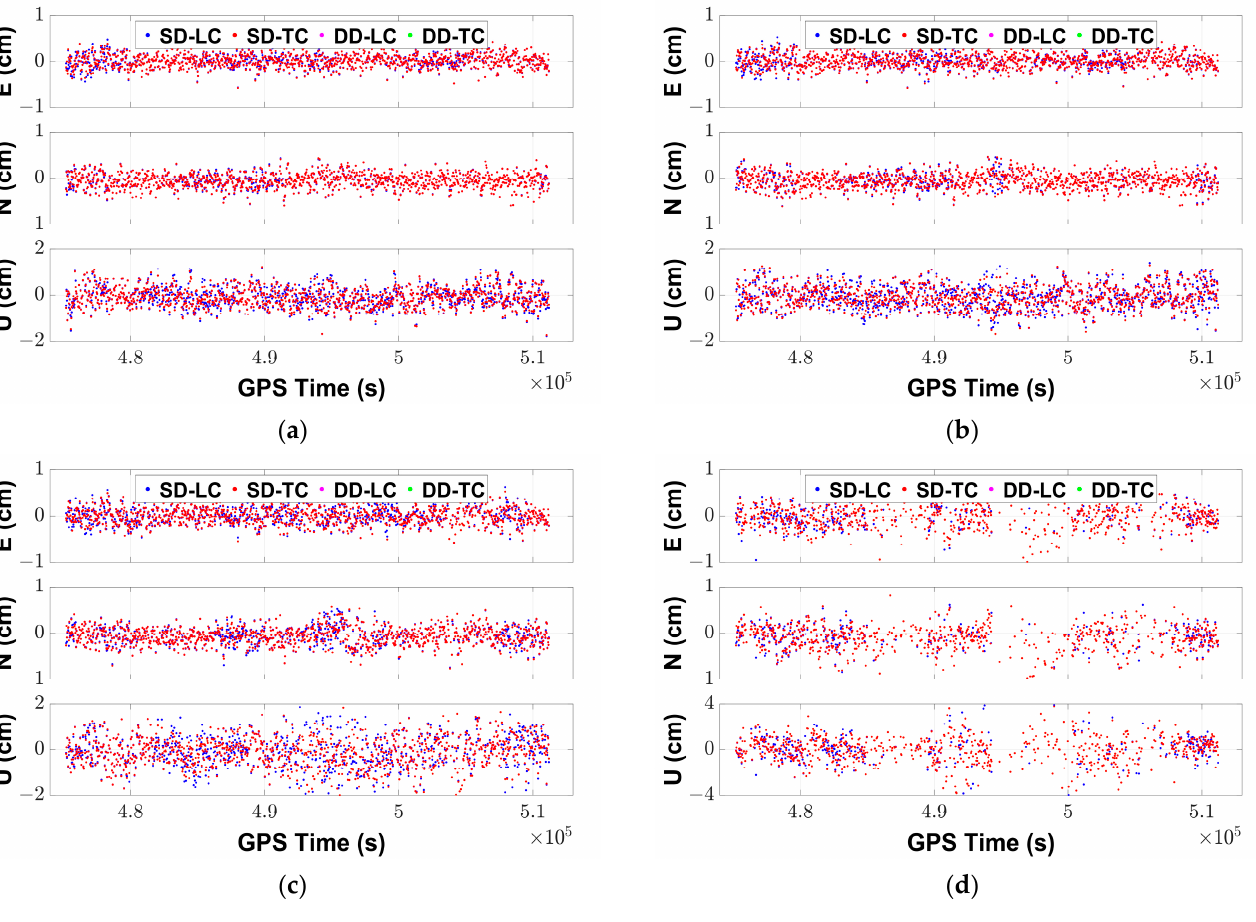
Figure 4. The positioning error series of the DD-LC, DD-TC, SD-LC, and SD-TC models under different elevation cutoff angles in the single-epoch solution: ( a ) 10°; ( b ) 20°; ( c ) 30°; and ( d ) 40°.